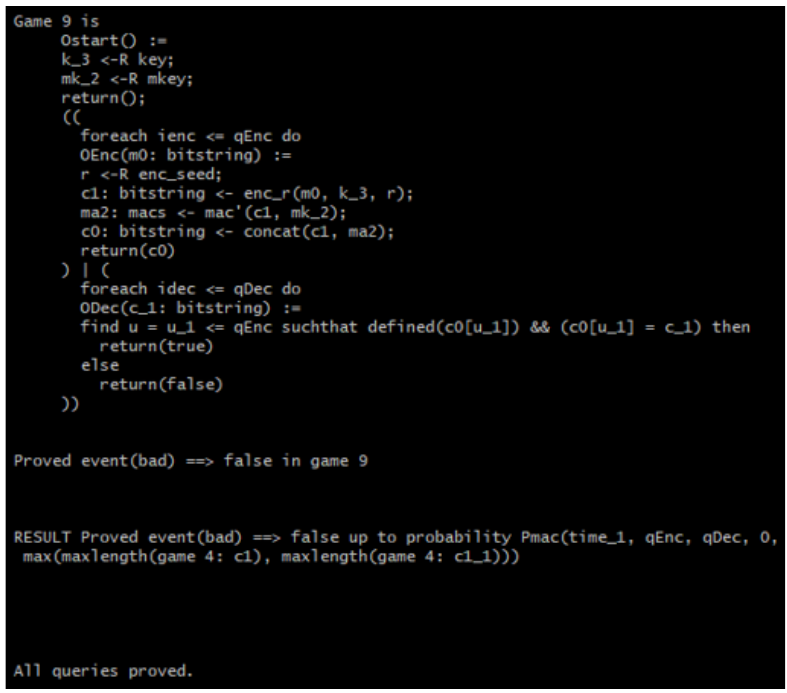
Figure 14. Output of INT_CTXT Verification of Platoon Key Update Phases.